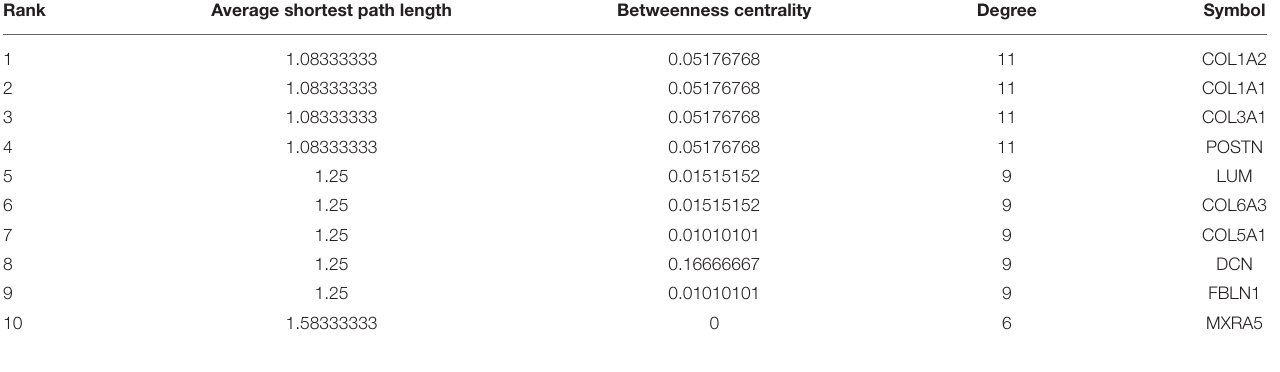
TABLE 3 | The top 10 hub genes in the shared DEG PPI network.